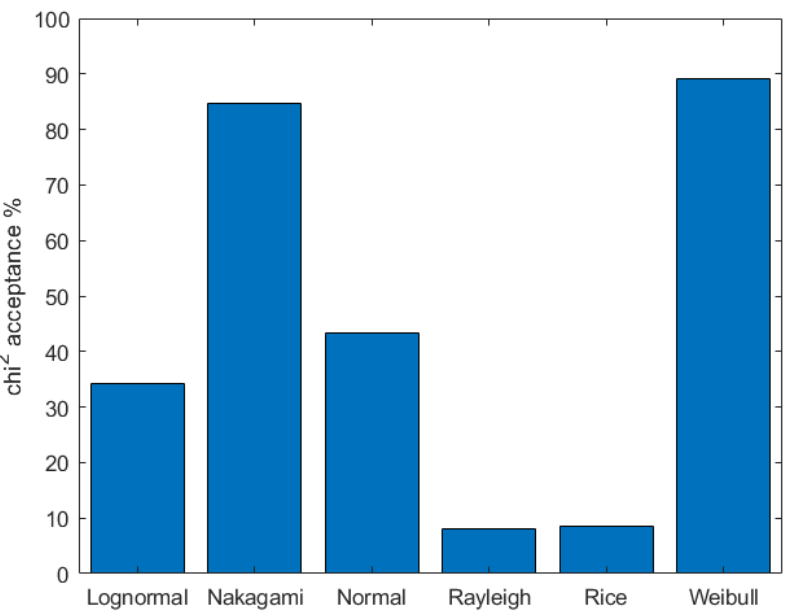
Figure 5. Comparison among distributions best-fitting the measured fast variations, in terms of percentage of acceptation of Pearson’s goodness-of-fit χ 2 test.